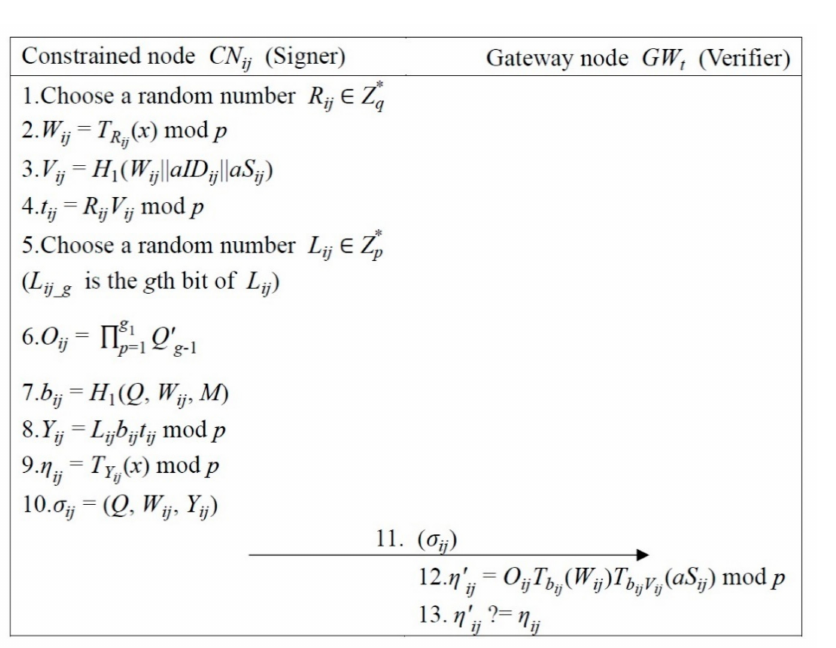
Figure 7. Anonymous signature and verification phase of proposed